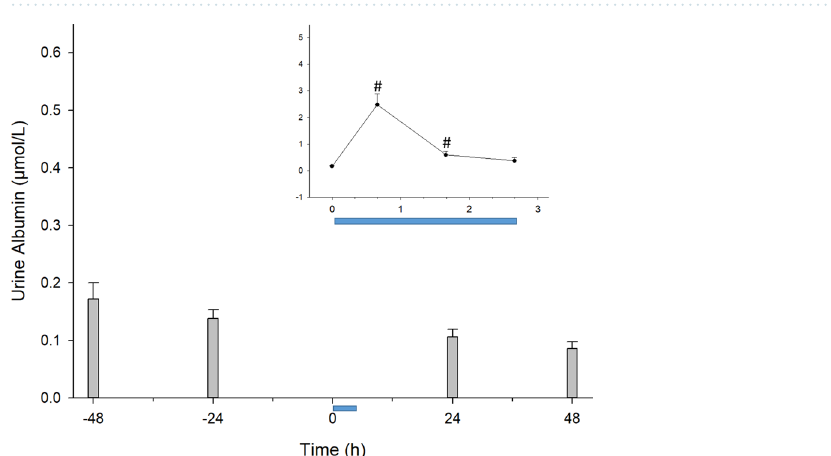
Figure 7. The CCombat protocol led to a 16-fold transient increase in albuminuria. #Pre vs . Post: p < .001; effect size = 1.4; statistical power = 0.99; #Pre vs . + 60 min: p < .001; effect size = 0.7; statistical power = 0.81. The blue bar represents the CCombat protocol in scale in both graphs. AVG ±